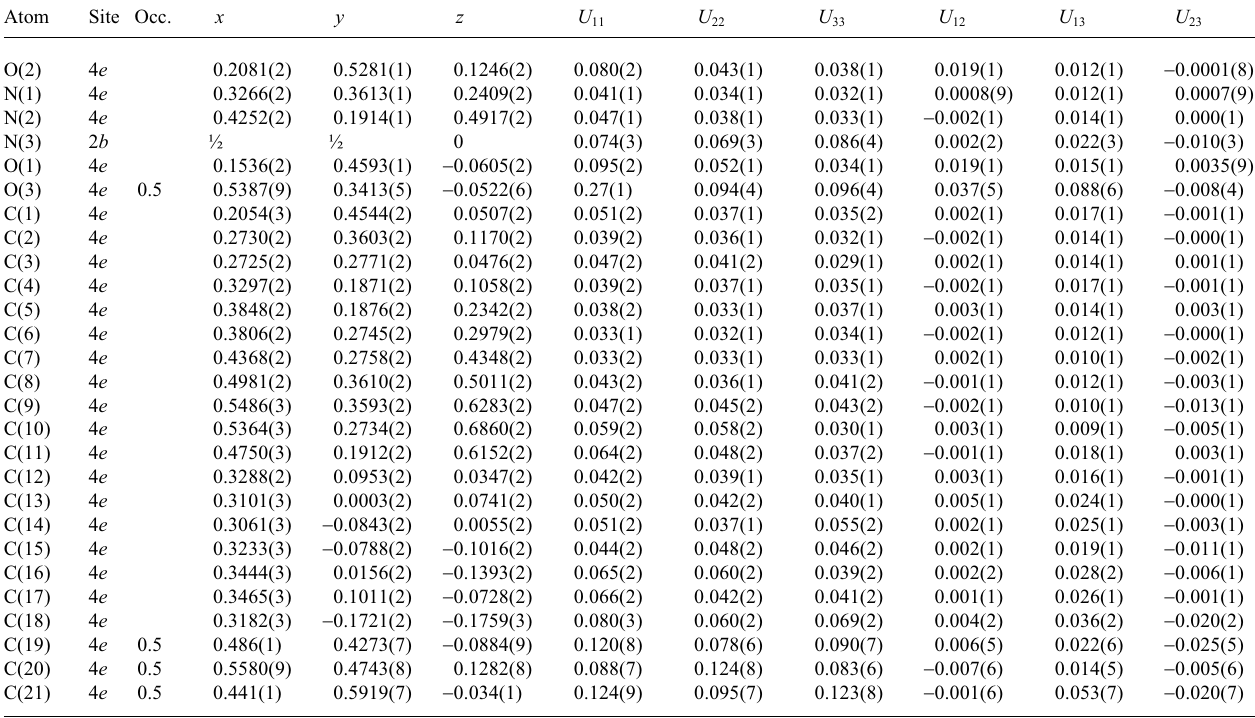
Table 3. Atomic coordinates and displacement parameters (in Å 2 ) . Atom Site